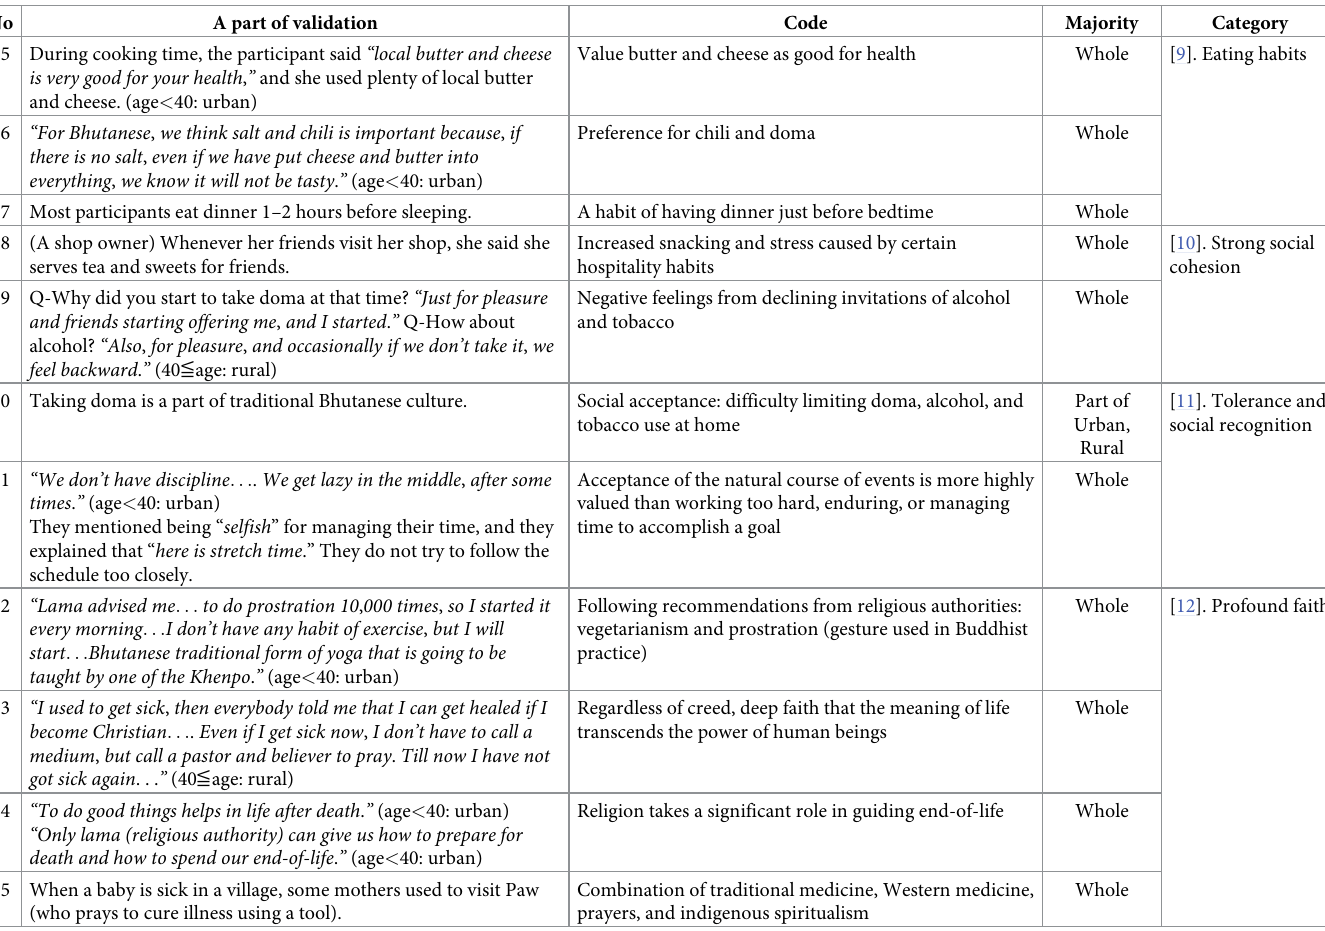
Table 8. Theme V: Traditional habits and value: Validation, code, categories and themes. No A part of